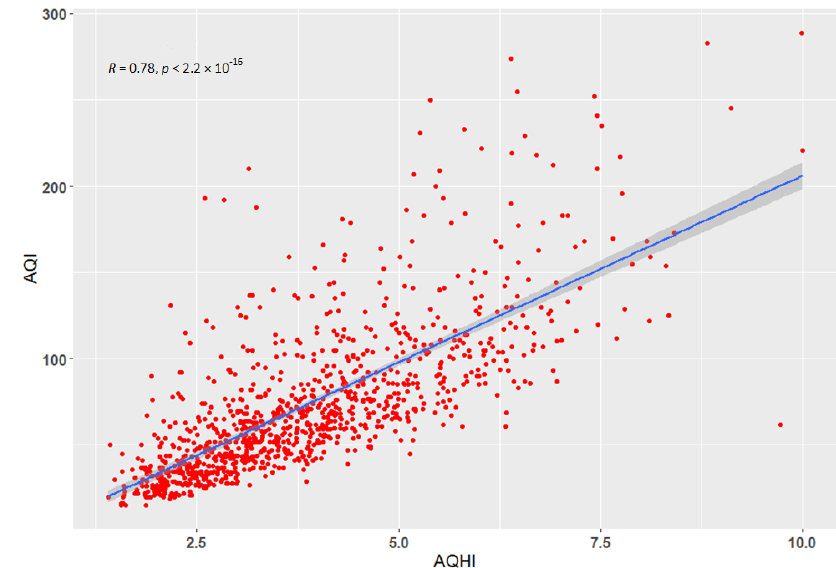
Figure 5. Correlation between the AQHI and AQI.